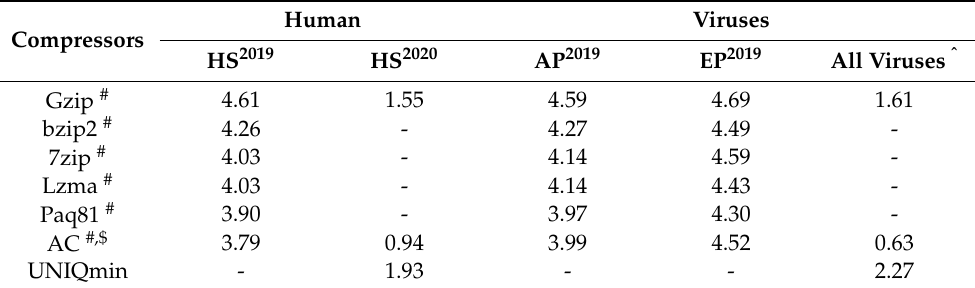
Table 3. Direct and indirect comparisons of the compression performance, in terms of bit-rate (bits per symbol; bps), between UNIQmin, Gzip (a widely used compressor that balances speed and compression), AC (typically showcases the best compression), and other existing protein